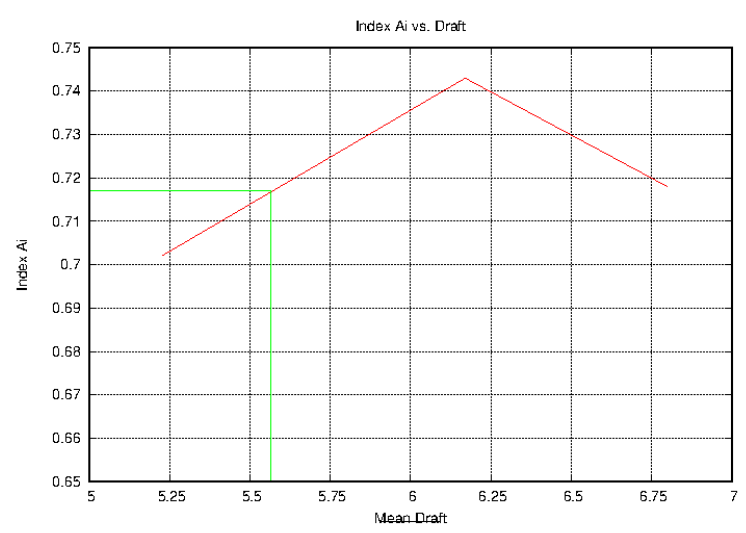
Figure 8. Index A i as a function of the draft for the EMSA2 RoPax.